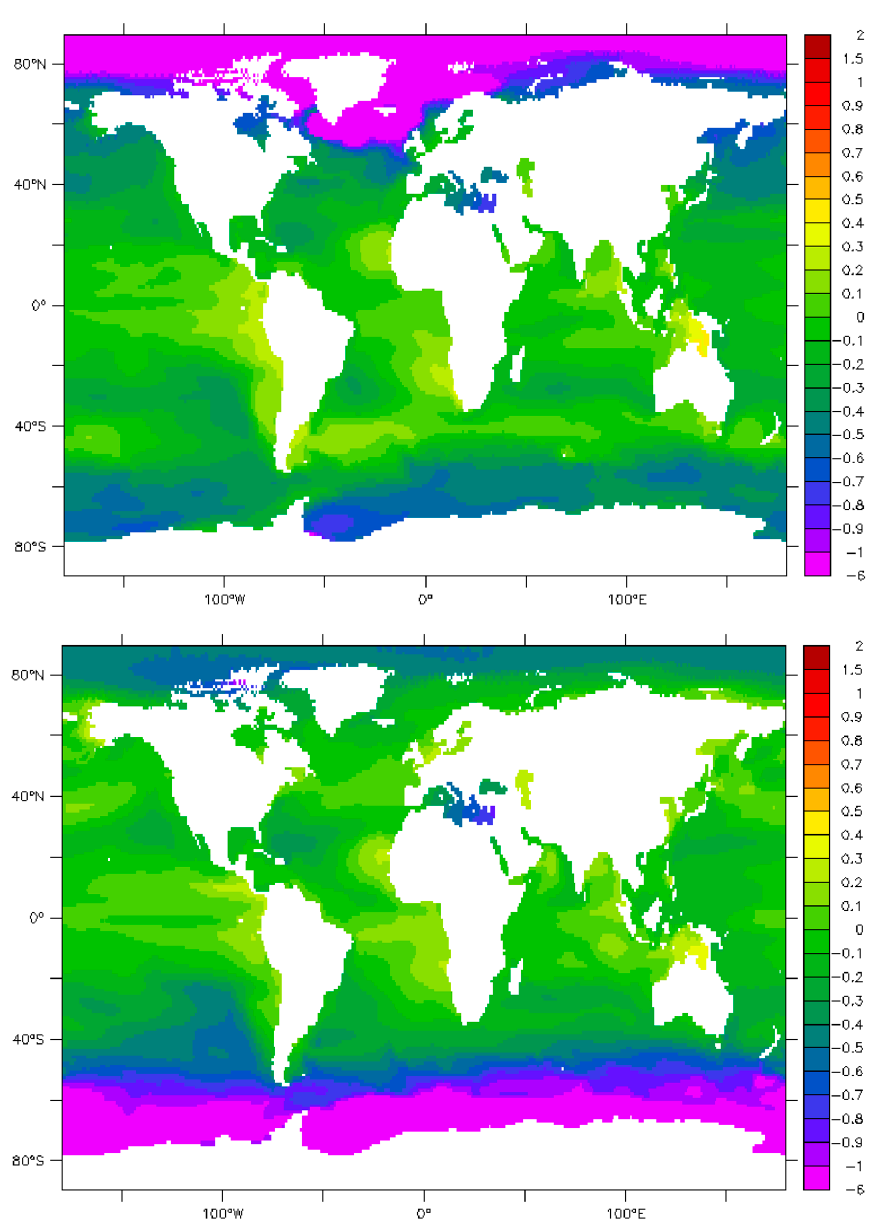
Figure 3. Log surface pressure maps ( Δ tension) constructed as in Figure 2, but with lipid levels returned to baseline. The color bar has been set so that a reference range of 0.3–3 mN/m is central ( − 0.5 to 0.5 in log units). May and November monthly averages are shown for a typical year near the turn of the millennium.